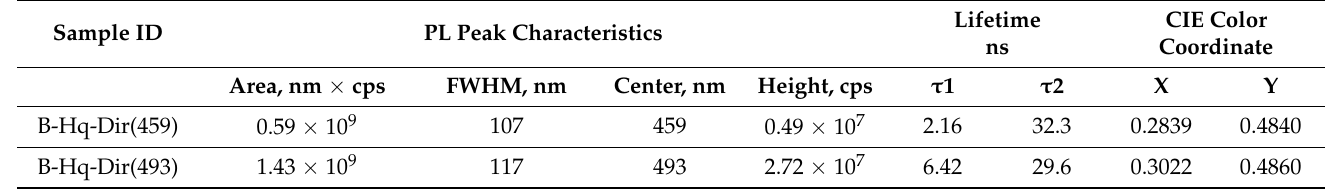
Figure 7. PL decay kinetics of BLC preparations obtained by heterophase synthesis. Table 2. PL characteristics of BLC preparations obtained by heterophase synthesis.